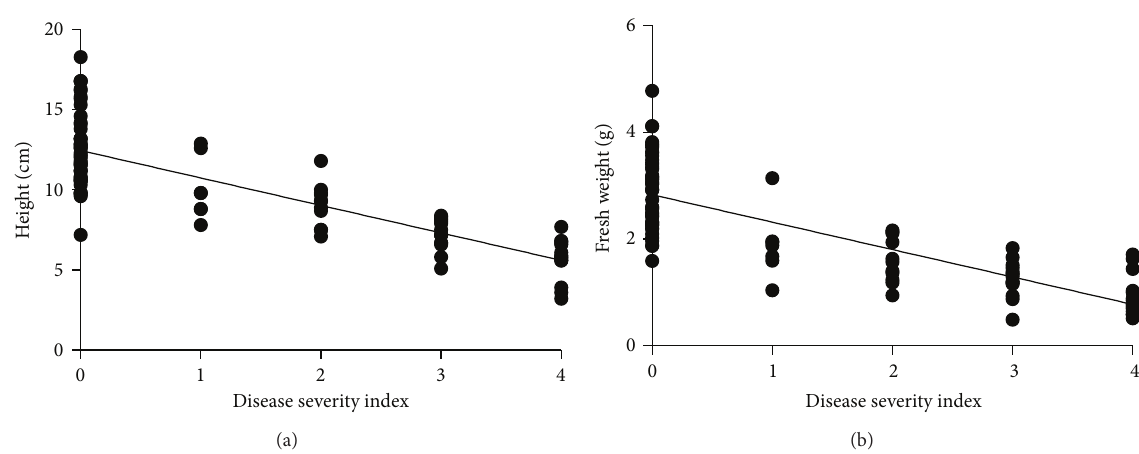
Figure 2: Correlation between clubroot disease incidence and plant height (a) and fresh weight